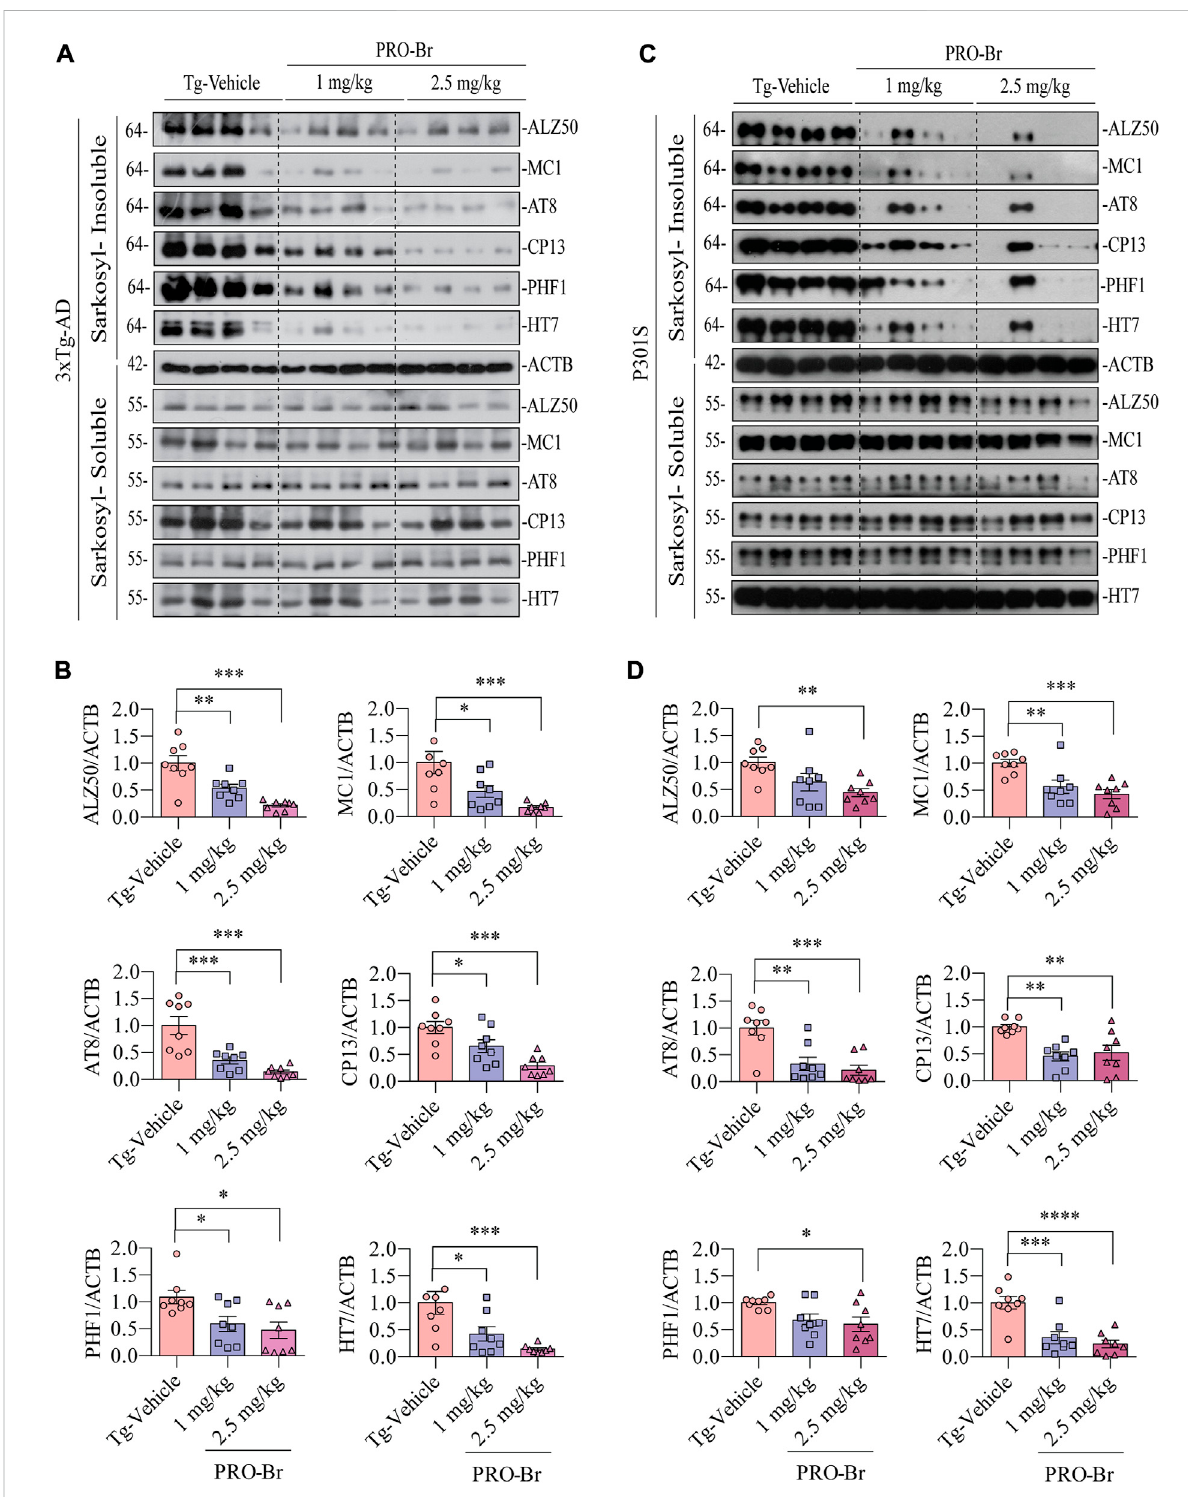
FIGURE 3 PRO-Br reduced the insoluble phospho-tau in AD mice. PRO-Br speci fi cally decreased sarkosyl-insoluble tau in (A-B) 3xTg-AD and (C-D) P301S mice models. Data is represented as mean ± SEM. N = 8 in each group, the statistical signi fi cance are * p < 0.05, ** p < 0.01, *** p < 0.001 (Tg-PRO-Br/PRO V.